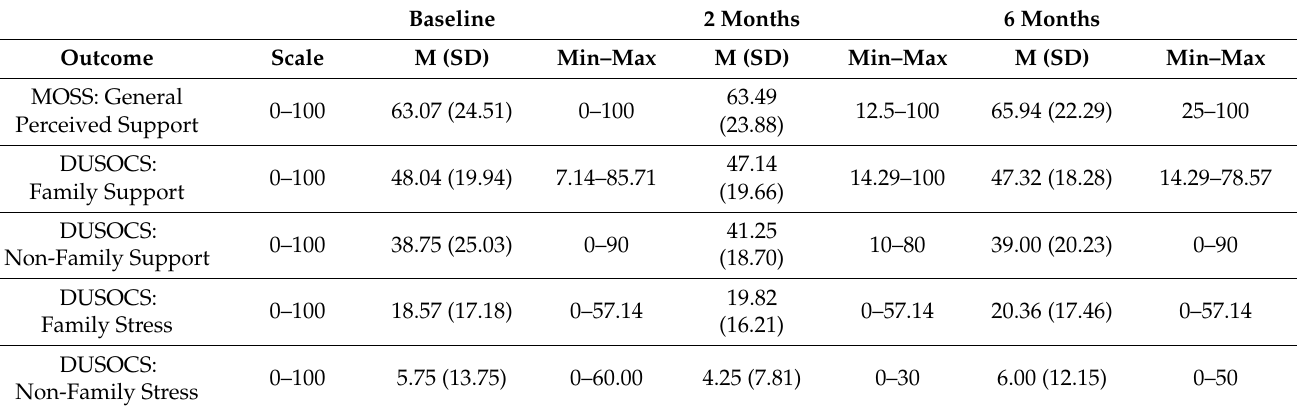
Table 2. Descriptive statistics at Baseline, 2 Month Bereavement, and 6-month Bereavement (n =